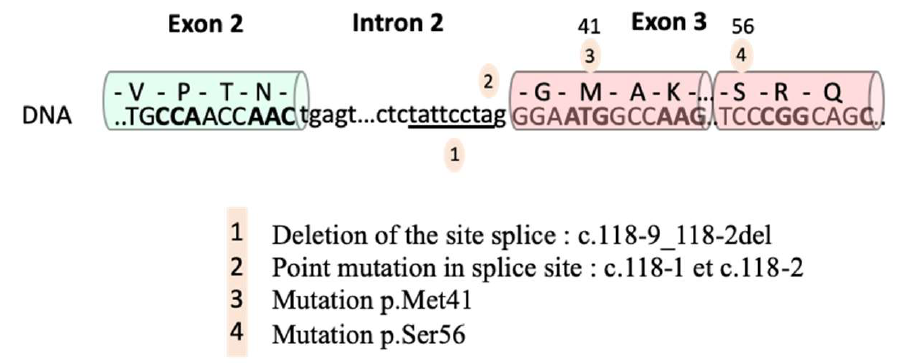
Figure 1. Mutations in the UBA1 gene associated with VEXAS syndrome. According to Templé et al.